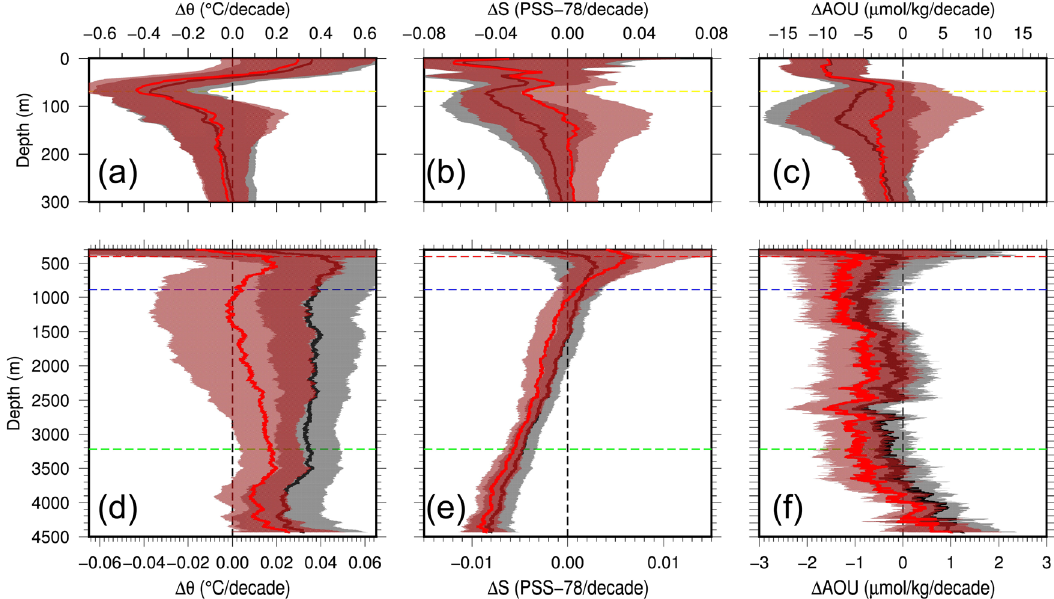
Fig. 4 Observed and water-mass change components of multi-decadal trends in the core region in the Australian-Antarctic Basin (core AAB) for the potential temperature, salinity, and apparent oxygen utilisation (AOU). The left ( a , d ), middle ( b , e ), and right ( c , f ) panels indicate the vertical pro fi les of the linear trends in potential temperature, salinity, and AOU, respectively; shallow and deep components are given in the upper ( a – c ) and lower ( d – f ) panels, respectively. In each panel, black and red lines indicate the observed and water-mass change components of the linear trends, respectively, with shaded areas indicating the 95% con fi dence interval. The dashed yellow, red, blue and green lines are de fi ned in Fig.